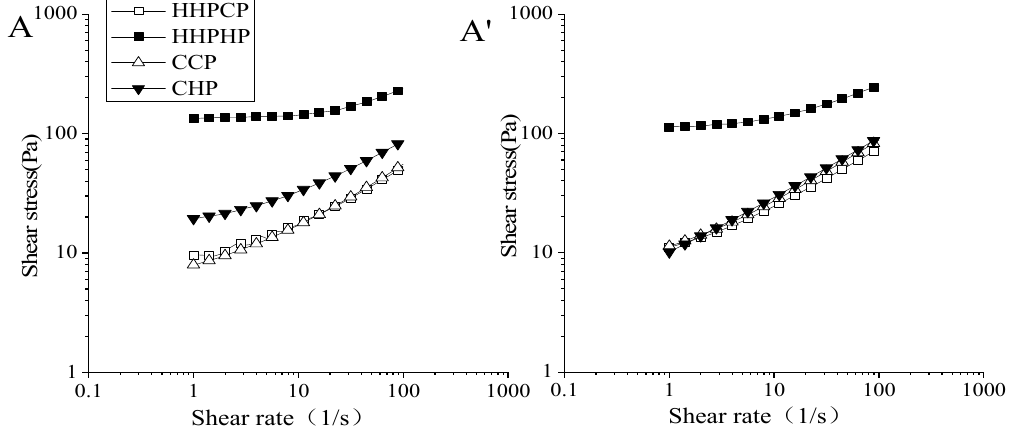
Figure 6. Flow curves of O/W emulsions prepared from pectin extracted by different methods at 0 ( A ) and day 30 ( A’ day 0 ( A ) and day 30 ( A’ ).